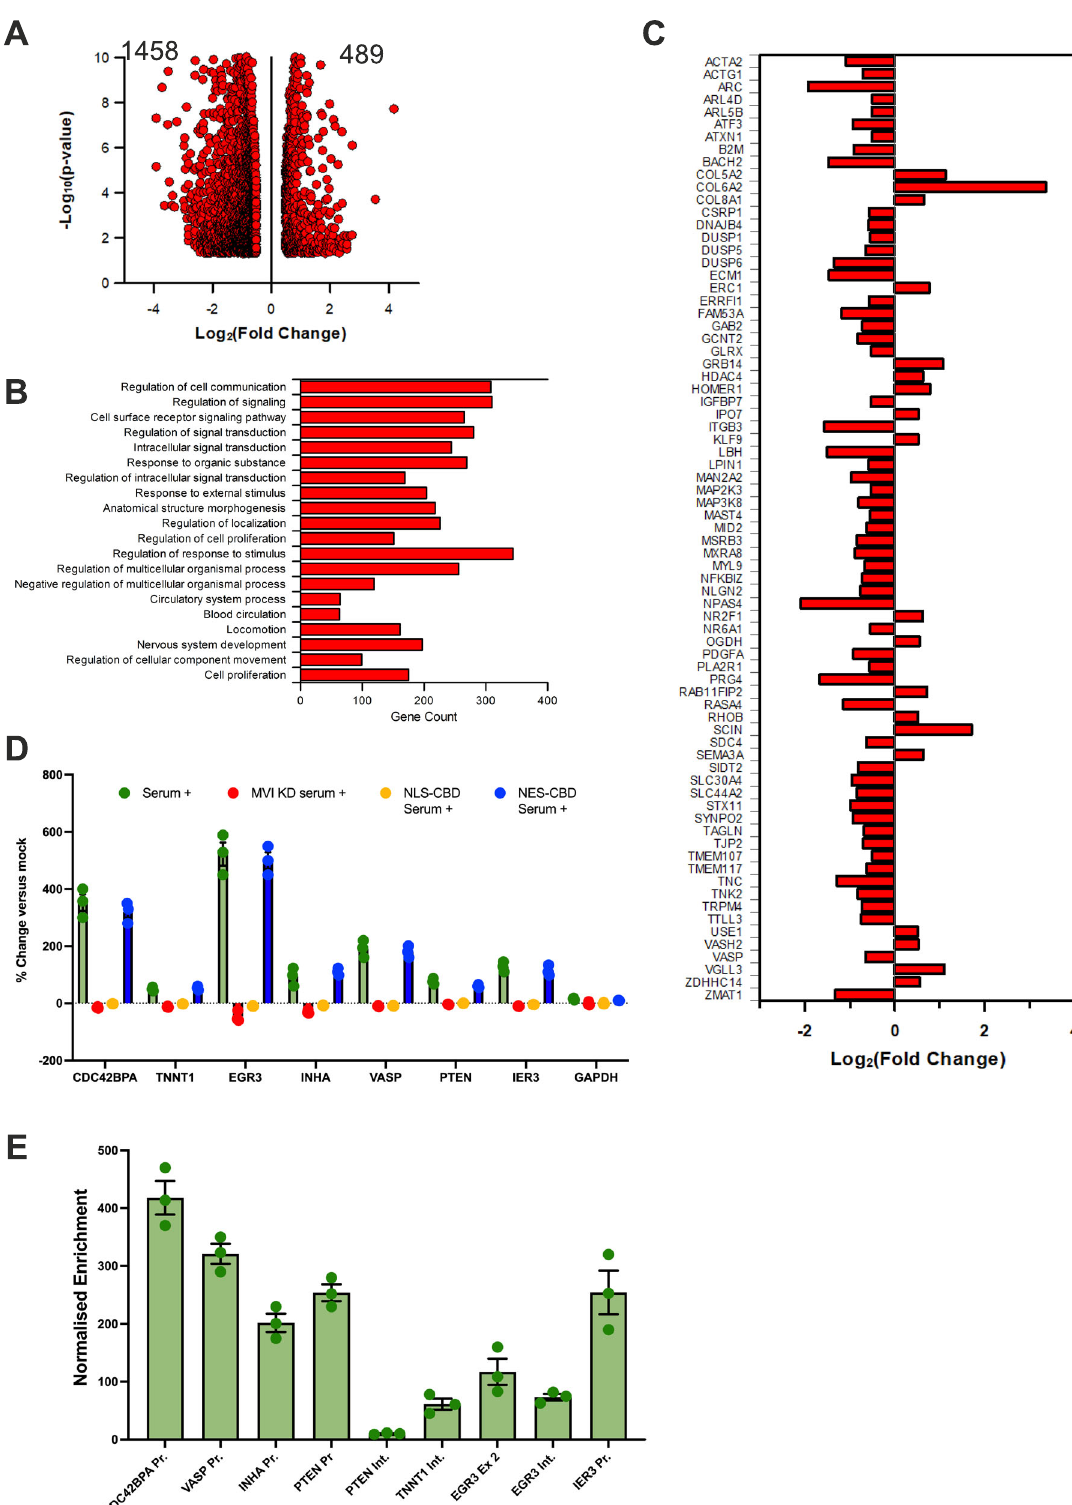
Fig. 7 Myosin VI dependent changes in gene expression. A Volcano plot of differentially-expressed genes from RNA-seq following MVI knockdown. p values are calculated using the Wald test. Western blots are shown in Supplementary Fig. 17 for the MVI knockdown. B GO terms, with gene count, for Biological Process corresponding to the genes negatively expressed following MVI knockdown. GO terms are plotted based on signi fi cant enrichment, as shown in Supplementary Table 1. C Plot of gene expression changes for serum-responsive genes within the list of differentially-expressed genes following MVI knockdown. D RT-qPCR Gene expression analysis of fi ve serum-responsive genes and housekeeping gene GAPDH with treatment of serum alone, serum following MVI KD, and serum following transfection with either NLS-CBD or NES-CBD (See Supplementary Fig. 17 for western-blot for knockdown). Data are plotted relative to non-stimulated expression from three independent experiments. Error bars represent SEM from three independent experiments. E MVI ChIP against labelled loci. Values are the average of three independent experiments. Error bars represent SEM from three independent experiments. NATURE COMMUNICATIONS| (2022) 13:1346 |https://doi.org/10.1038/s41467-022-28962-w|www.nature.com/naturecommunications